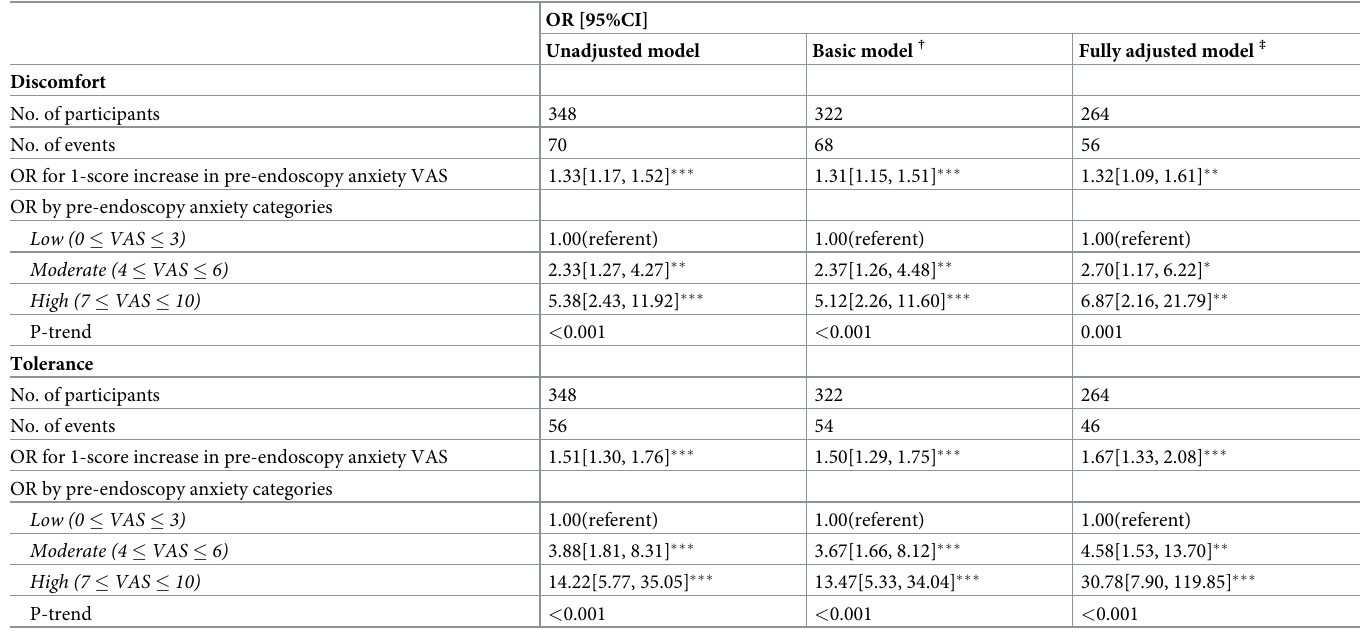
Table 2. Associations of pre-endoscopy anxiety with discomfort and